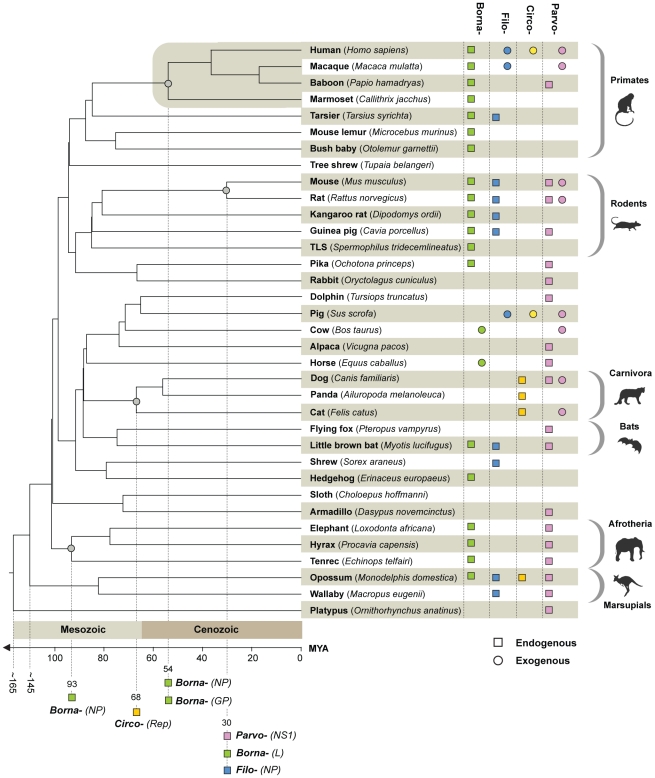
Timescaled phylogenetic tree of mammals screened in this study (after Bininda-Emonds et al
[42]) showing the known distribution of EVEs and of exogenous Borna-, Filo-, Circo-, and Parvoviruses.Grey circles indicate nodes at which orthologous EVE insertions were identified. For all orthologous insertions identified here and elsewhere [11], [22], the virus family and genomic region represented by the ortholog is shown. Abbreviation: TLS = Thirteen-lined ground squirrel.